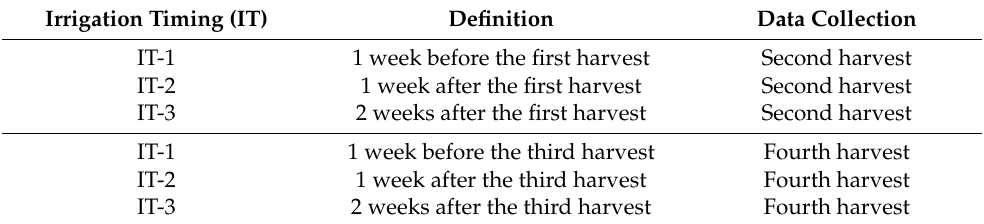
Table 2. Definition of the experimental treatments. The different irrigation timings, i.e., treatments applied around the first and the third harvest were evaluated in the second and the fourth harvest, re-